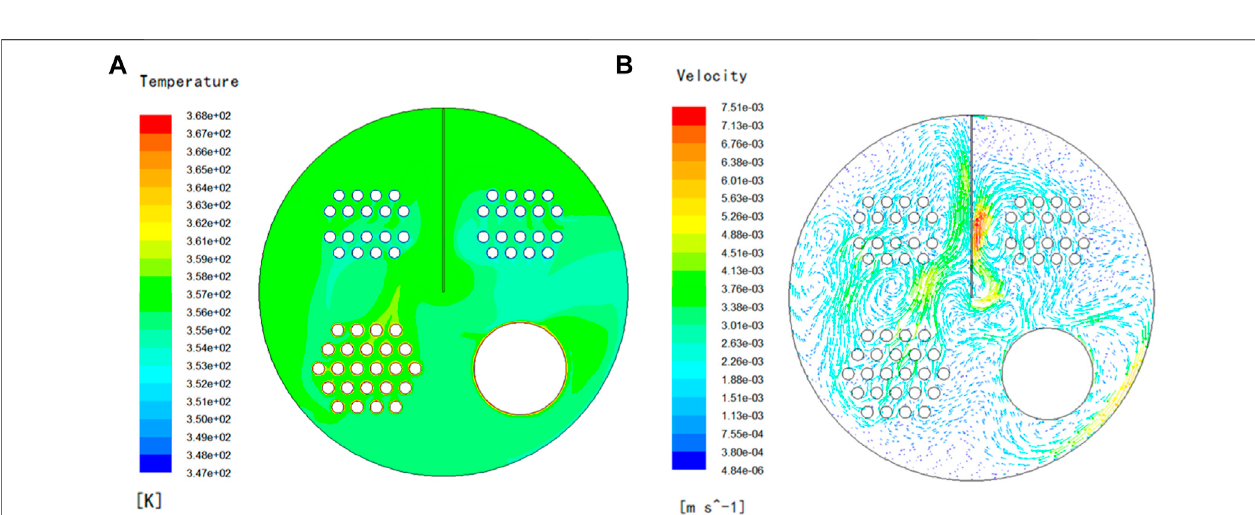
bundle (i.e., the heat utilized to heat up gas inside the convective tubes) is compared to the cylinder ’ s central temperature in the case without the guide plate in Figure 4 . With a fi ner grid system, the overall heat transfer rate and central temperature converge as predicted. The cumulative heat transfer rate inaccuracy between the fi nest grid with 1,170,000 cells and the grid with 423,000 cells is less than 0.6%, and the temperature at the cylinder center is less than 0.12%. It can be considered that this and a larger number of grids no longer affect the calculation results; considering the limited resources of the computer, the grid level of 423,000 cells may be employed to conduct research. The same grid-level setting procedure was adopted for all subsequent